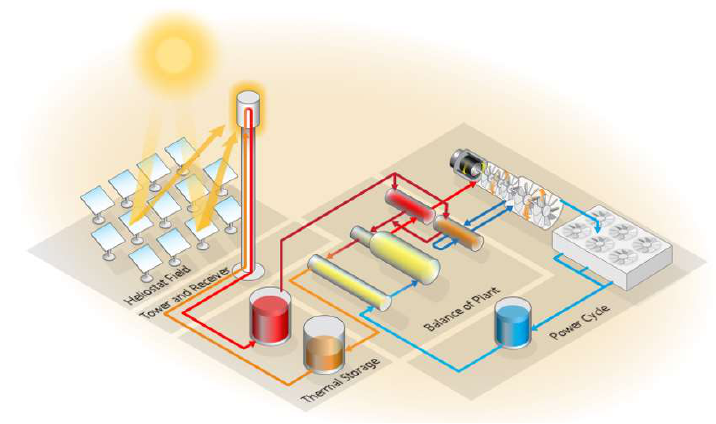
Figure 2. SAM sketch of a solar tower plant. Credit NREL/SAM.